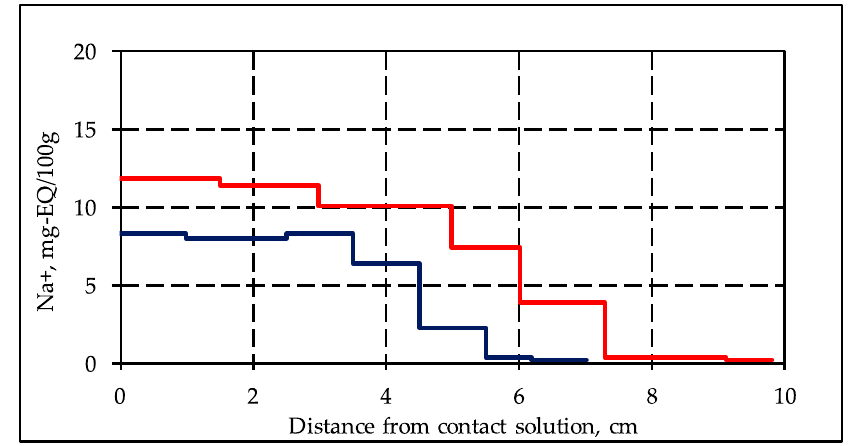
Figure 1. Salt ion accumulations (Na + ) in frozen sand samples (sand 1, W = 14%) containing (red line) and not containing (blue line) hydrate in porous media after 46 h of contact with 0.2N NaCl solution under the temperature − 4 °C.